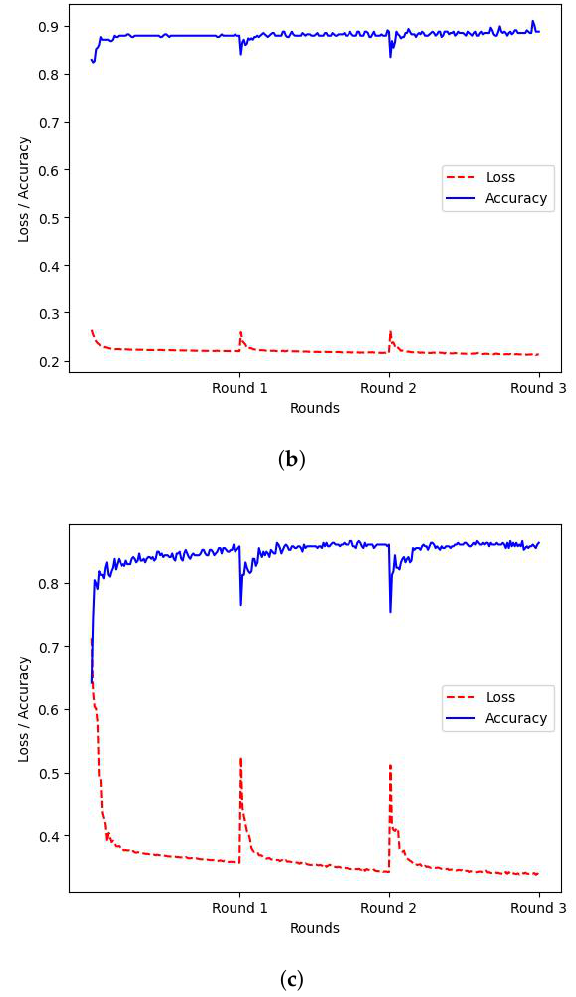
Figure 3. FL Training. X -axis: Federated Rounds, Y -axis: value of accuracy(blue and loss (red). ( a ) Worker 1 (W1) FL Training Metrics; ( b ) Worker 2 (W2) FL Training Metrics; ( c ) Worker 3 (W3) FL Training